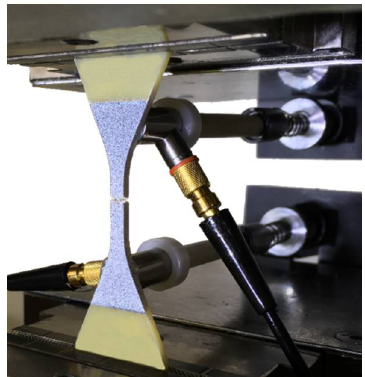
Figure 2. Test set-up: broken specimen with acoustic sensors and speckle pattern for